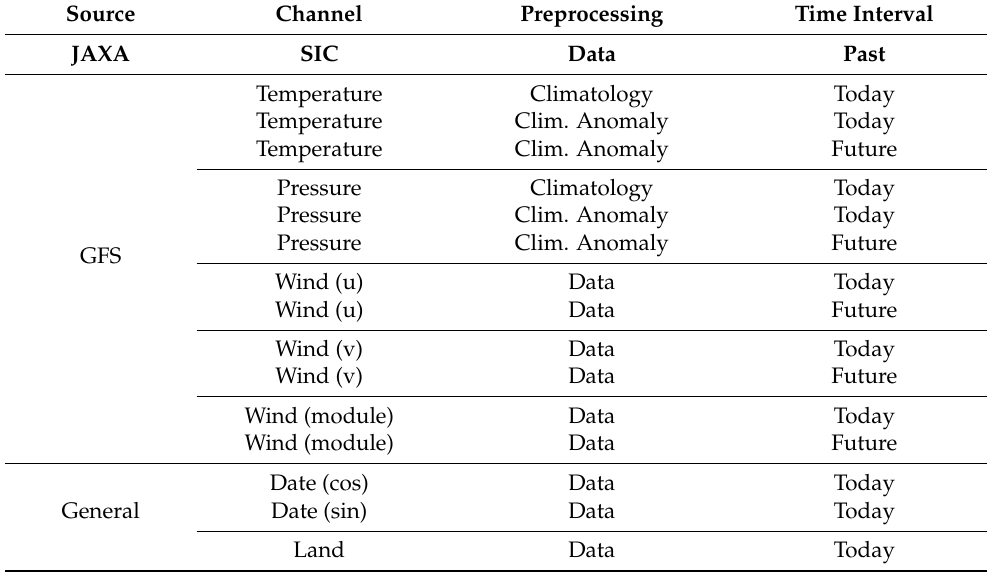
Table 3. Chosen configuration of the inputs for the experiments. “Data” in preprocessing means that no preprocessing except standardizing was performed. “Past” time interval means stacking all the specified maps for all the days in the past, including the last observable day (“Today”). “Future”— stacking all the forecasts for the output days (3 for S-regime and 1 for R-regime). In R-regime, the corresponding forecasts from the last observable day replace data and forecasts of the coming days, so that no yet unobserved data or forecasts leak to the model from the future. Source Channel Preprocessing Time Interval JAXA SIC Data Past Temperature Climatology Today Temperature Clim. Anomaly Today Temperature Clim. Anomaly Future Pressure Climatology Today Pressure Clim. Anomaly Today Pressure Clim. Anomaly Future GFS Wind (u) Data Today Wind (u) Data Future Wind (v) Data Today Wind (v) Data Future Wind (module) Data Today Wind (module) Data Future Date (cos) Data Today General Date (sin) Data Today Land Data